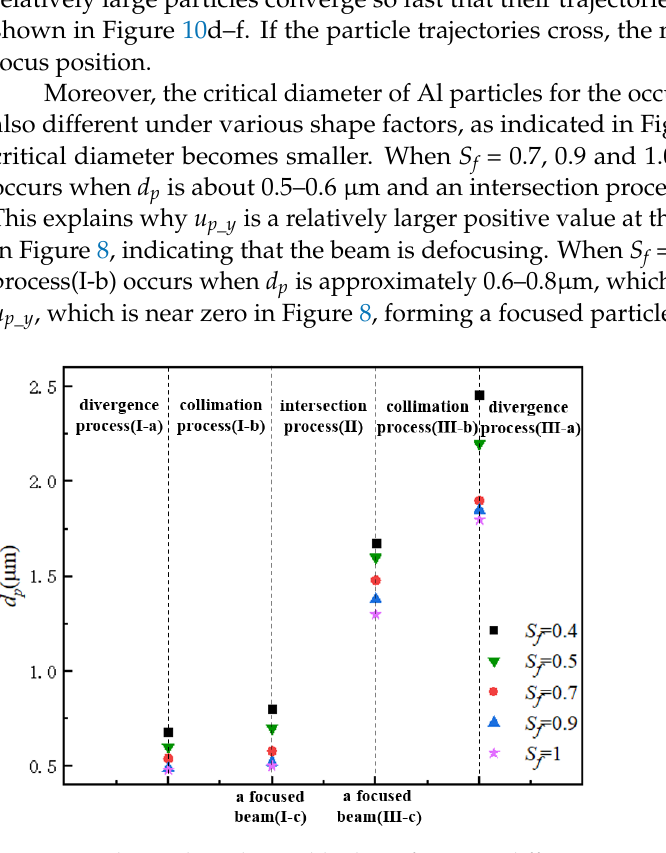
Figure 13. Diffusion radius of particles at the nozzle outlet. 6. Conclusions This paper numerically demonstrates the flow characteristic and motion trajectory of submicron particles in a converging–diverging micronozzle using the Euler–Lagrangian method. The results show that a particle beam can be produced through the effect of aer- odynamic focusing in the supersonic part of a fully expanded micronozzle flow field. The performance of the shape factor and particle density with various levels of inertia can be determined, allowing us to observe the resulting different particle velocities and trajecto- ries. By increasing the particle densities and shape factors, the particle focusing is stronger due to their high inertia, while the particle velocity is smaller with a larger shape factor. The velocity of the particles with small inertia better coincides with their gas velocity com- pared with that of larger ones. The dynamic focusing of particles is the result of the com- petition between inertia force and drag force. Both of the two forces are beneficial for the aerodynamic focusing of particles. Furthermore, the position of submicron particle focus- ing changes with particle inertia. As the particle size increases, the position of the particle trajectory intersection moves towards the nozzle throat at first and then it moves in- versely. Moreover, the thermophoretic force of the submicron particles has almost no ef- fect on aerodynamic focusing in a micronozzle. The result of this study is important in technological applications, such as controlling the speed of the submicron particle beam in a micronozzle or forming a collimated submicron particle beam, etc. The diffusion and